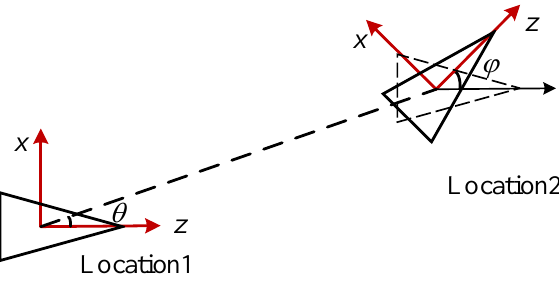
Figure 2. Camera motion scheme on the plane.